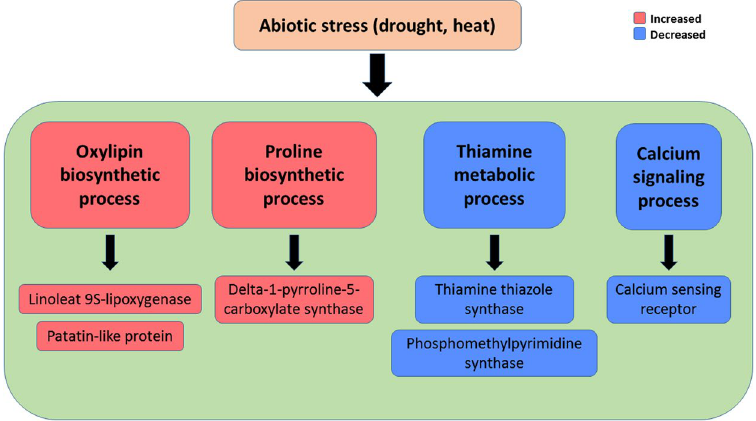
Figure 8. A comprehensive overview of transcriptional regulations under drought and heat stress in A. stolonifera